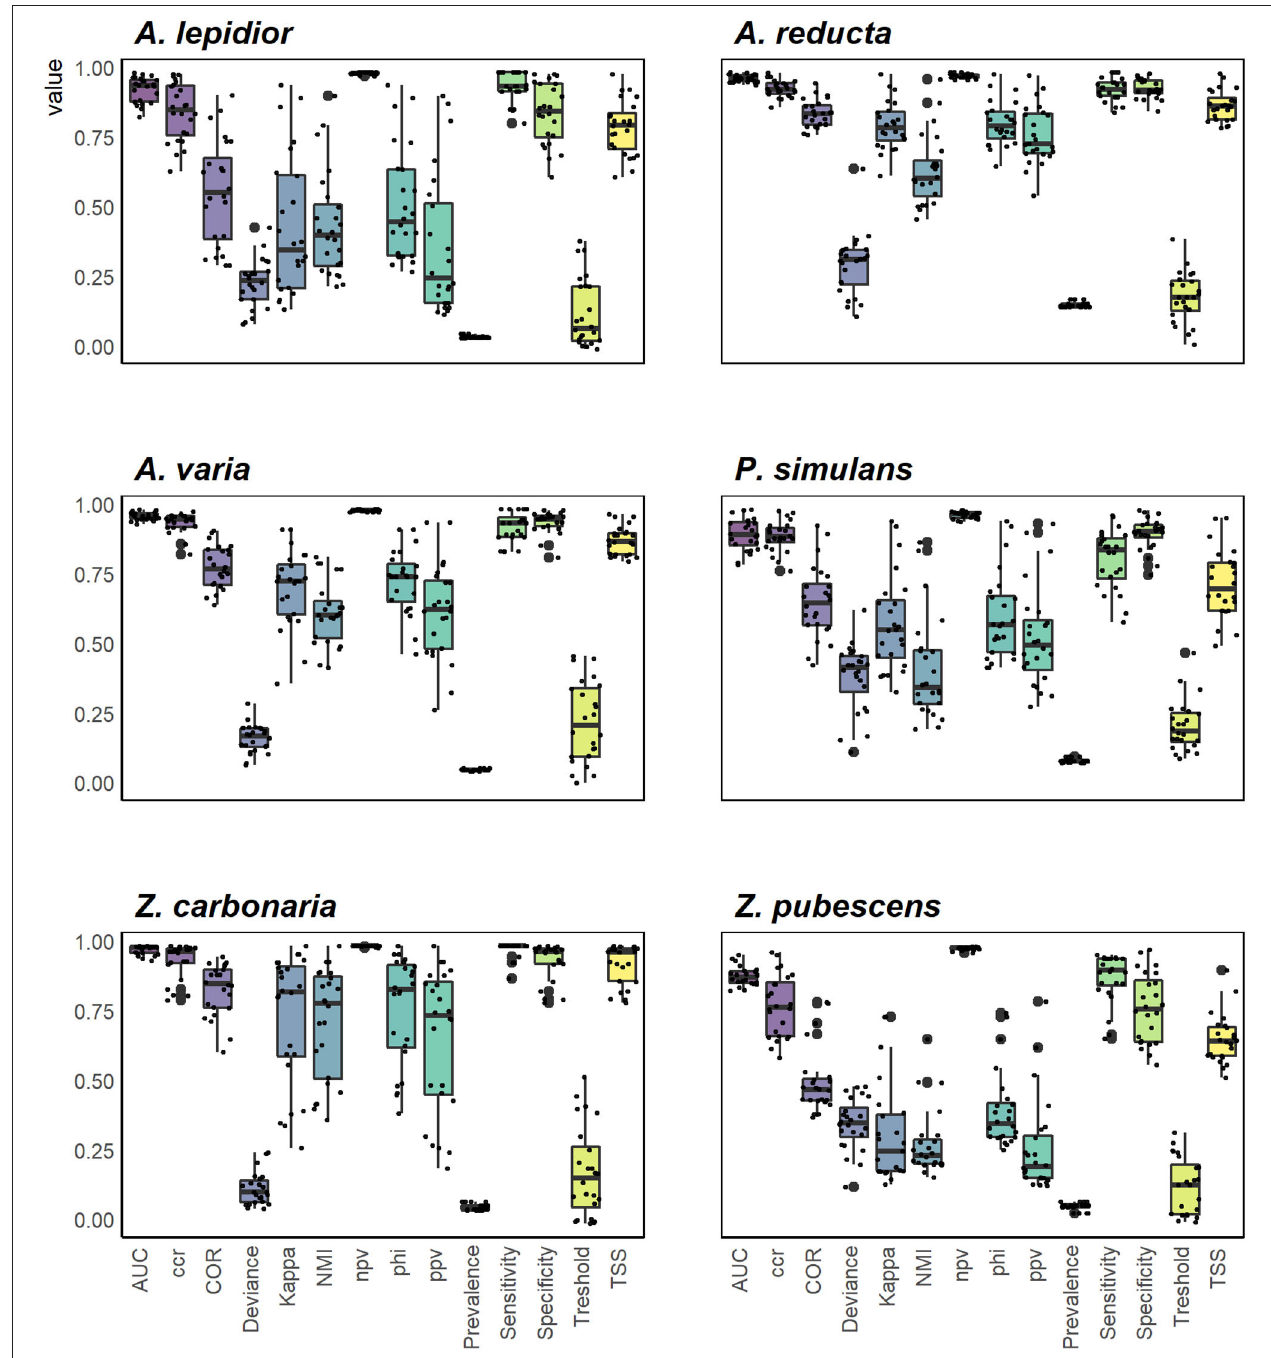
FIGURE 9 | Evaluation of ecological niche models of spittlebugs species across different metrics obtained from 24 model by each species.